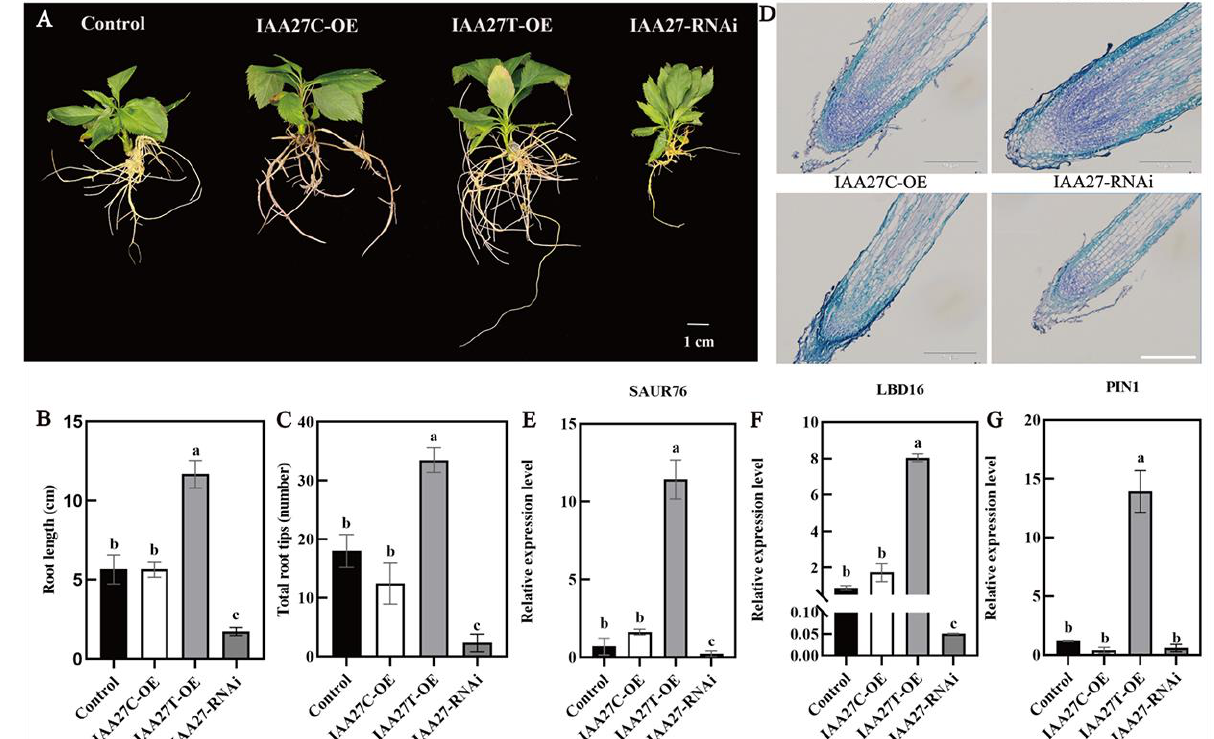
Figure 5. Overexpression and silenced lines of IAA27 in ‘GL3’. ( A – C ) The adventitious root phenotypes of transgenic plants and control plants in the presence of auxin (0.5 mol/L) for 50 days on 1/2 MS solid medium; the experiment was repeated three times and the phenotype was consistent. ( D ) MdIAA27 could influence the meristematic activity of root tips. Scale bars: 10 μm. ( E – G ) The gene expression of transgenic plants. Error bars indicate standard deviations (s.d.) from three biological replicates. Different letters represent significant differences ( p < 0.05).